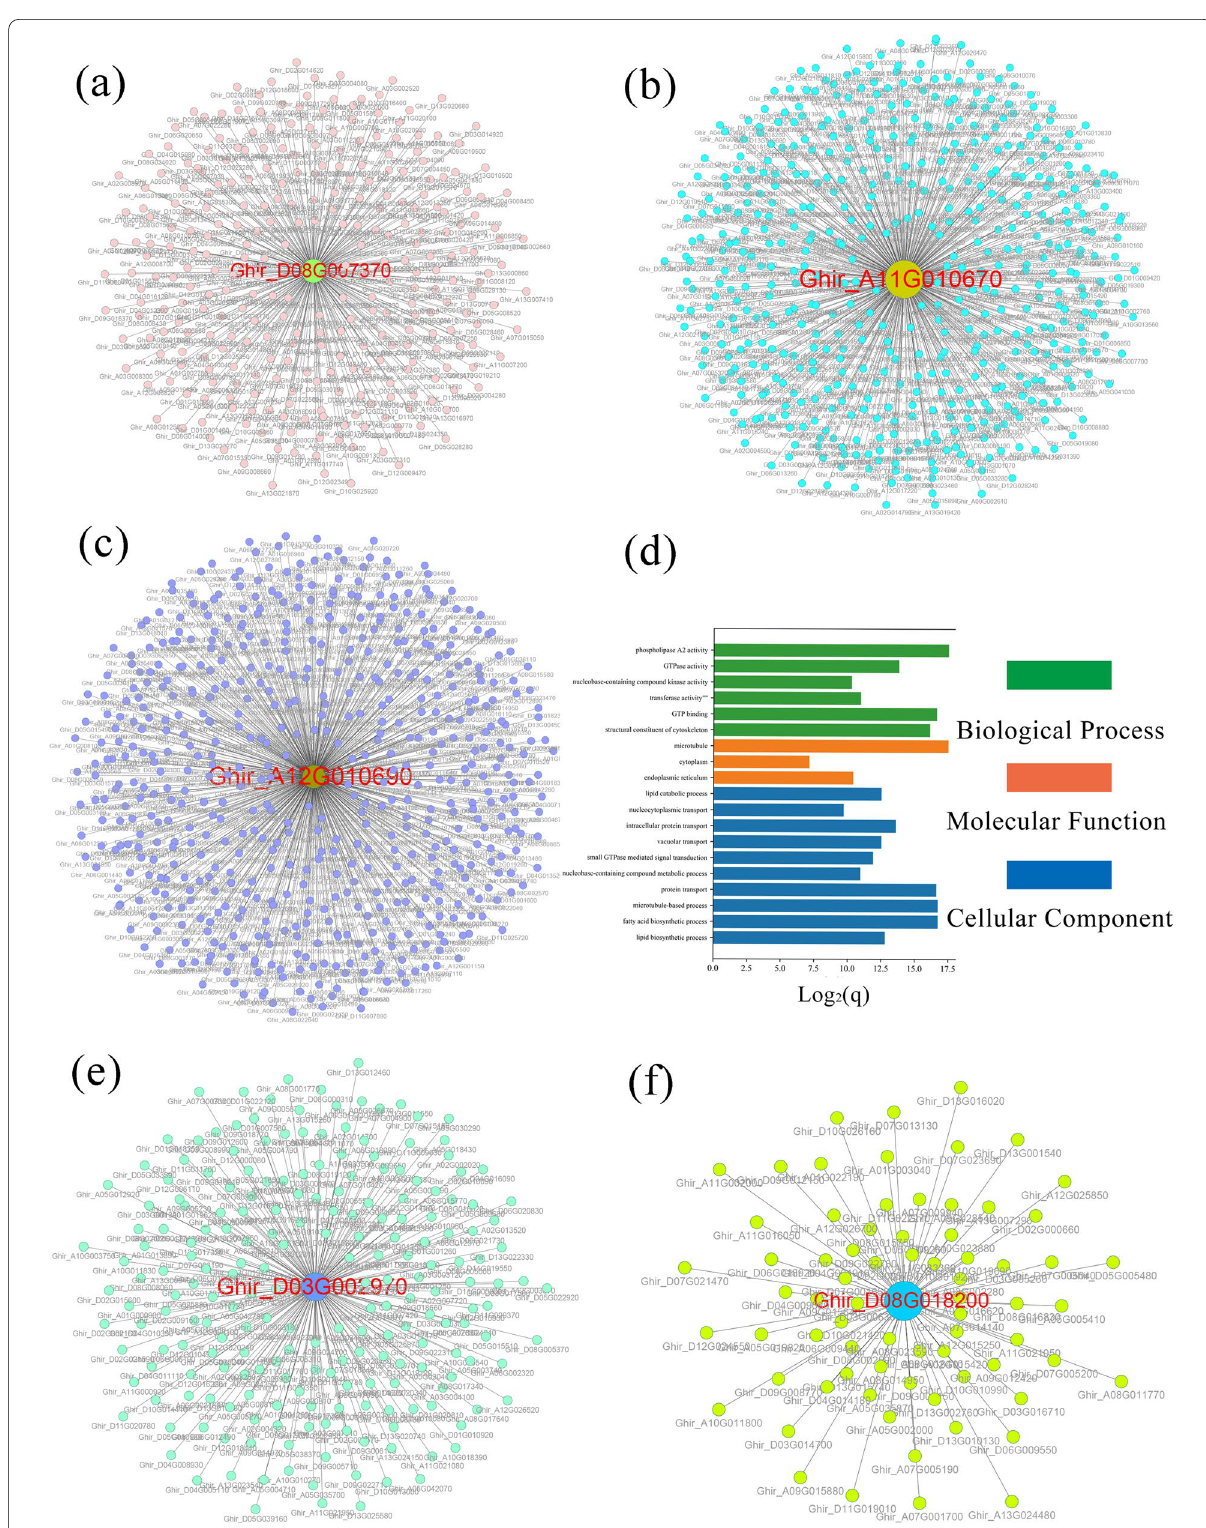
Fig. 6 Interaction networks of 5 Rho members. a interaction network of Ghir_D08G007370. b interaction network of Ghir_A11GG010670. c interaction network of Ghir_A12G010690. d GO enrichment of genes interacted with Ghir_A12G010690. e interaction network of Ghir_ D03G002970. f interaction network of